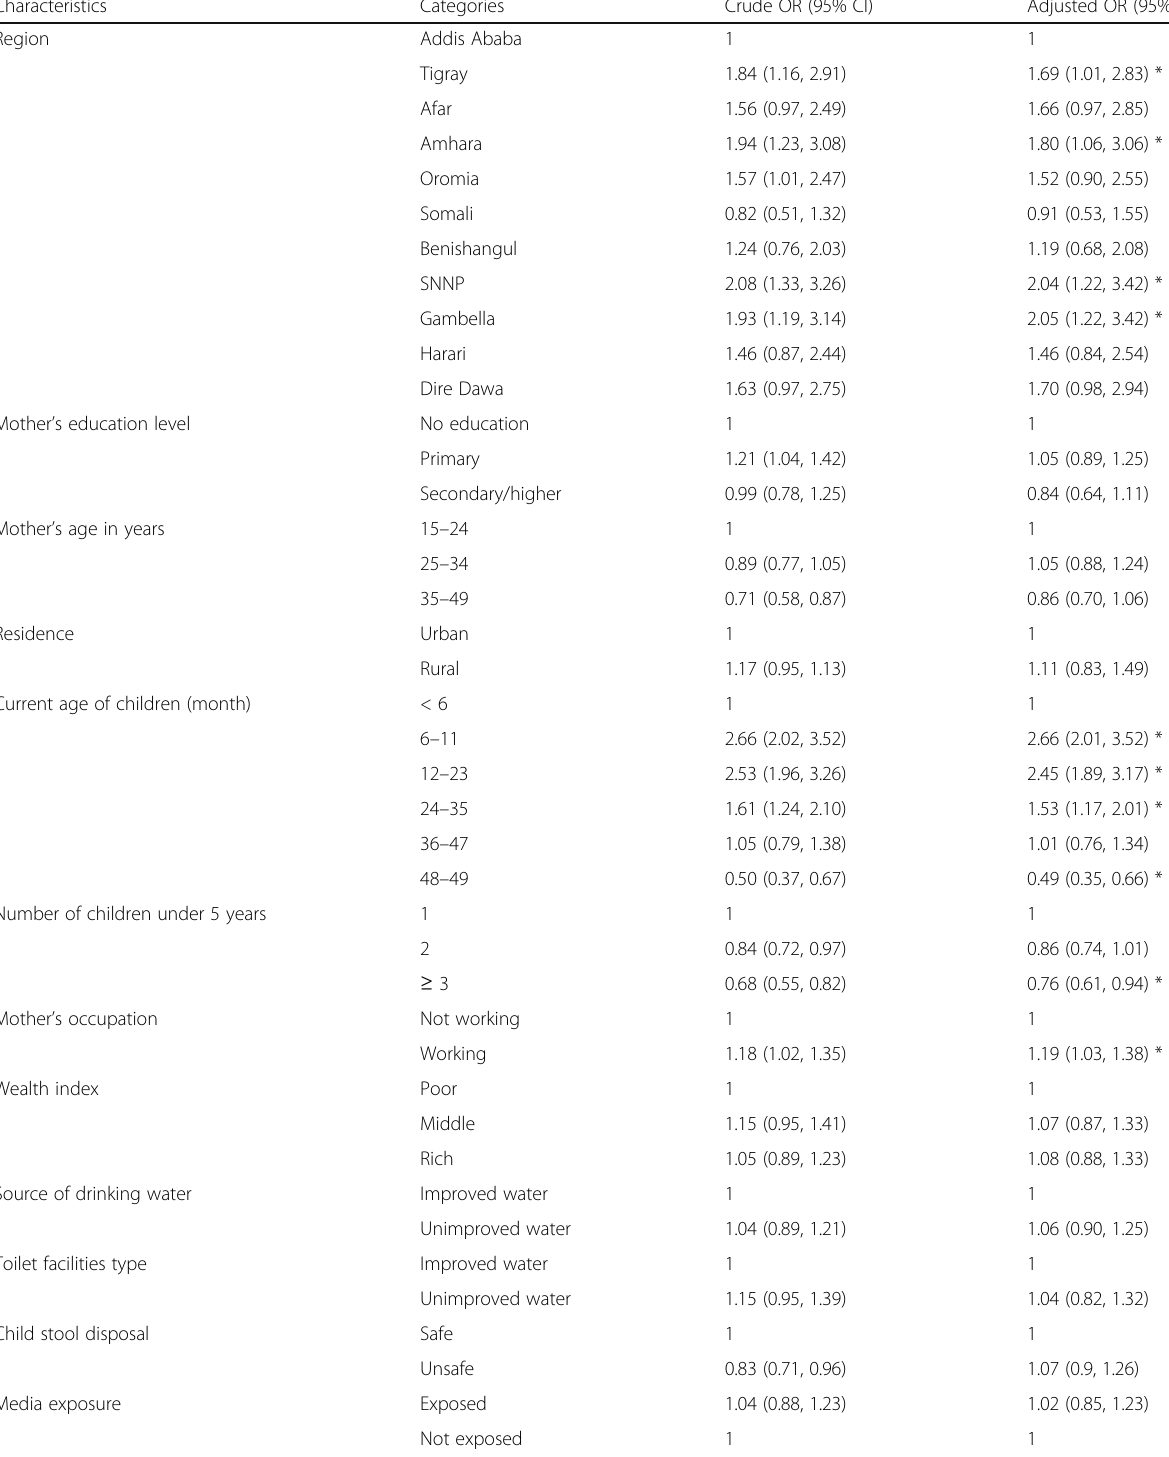
Table 3 Multilevel multivariable logistic regression analysis of childhood diarrhea among under-five children in Ethiopia, 2016